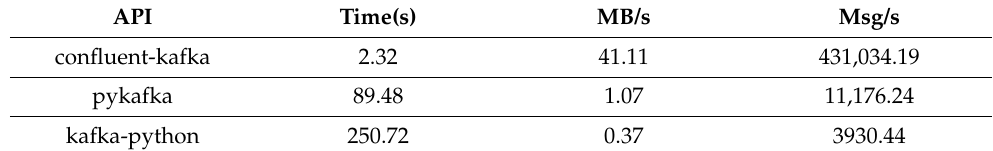
Table 1. Comparison of the throughput to Kafka producer with three Python APIs.